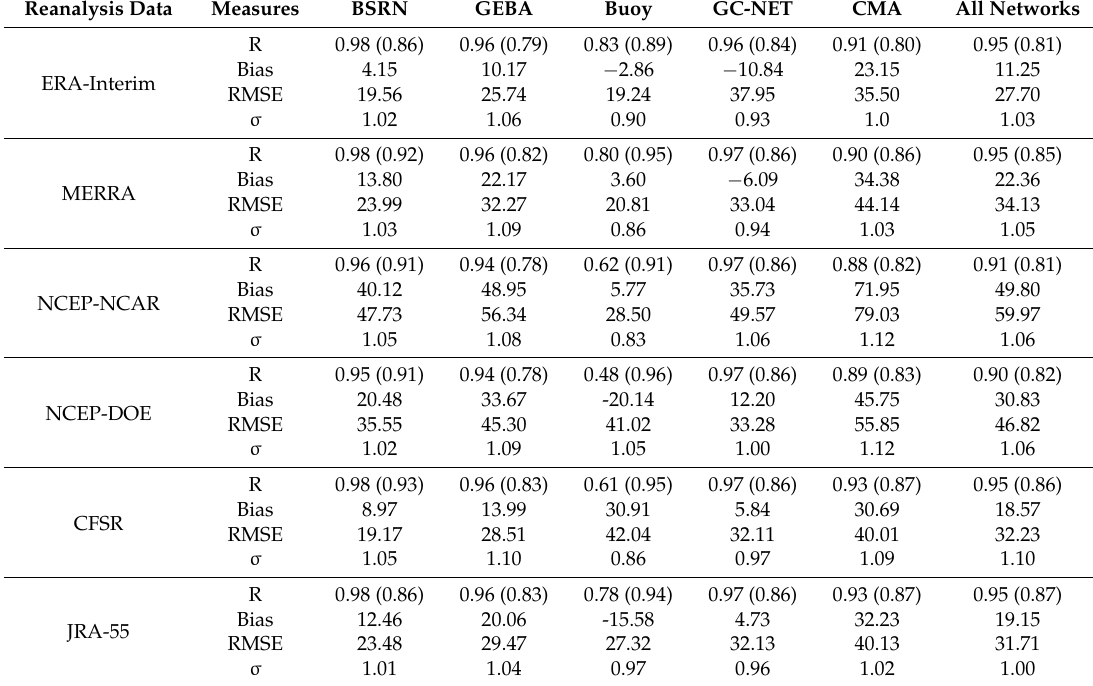
Table 2. Evaluation of the monthly R s from six reanalysis data sets using surface measurements collected from 674 stations from 2001 to 2009. The numbers in the brackets are the correlation coefficients after removing of the seasonal cycle. Units are W/m 2 for bias and RMSE.